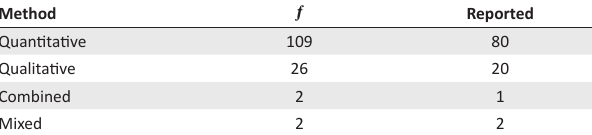
TABLE 2: Frequency of convenience sampling in method use. Method